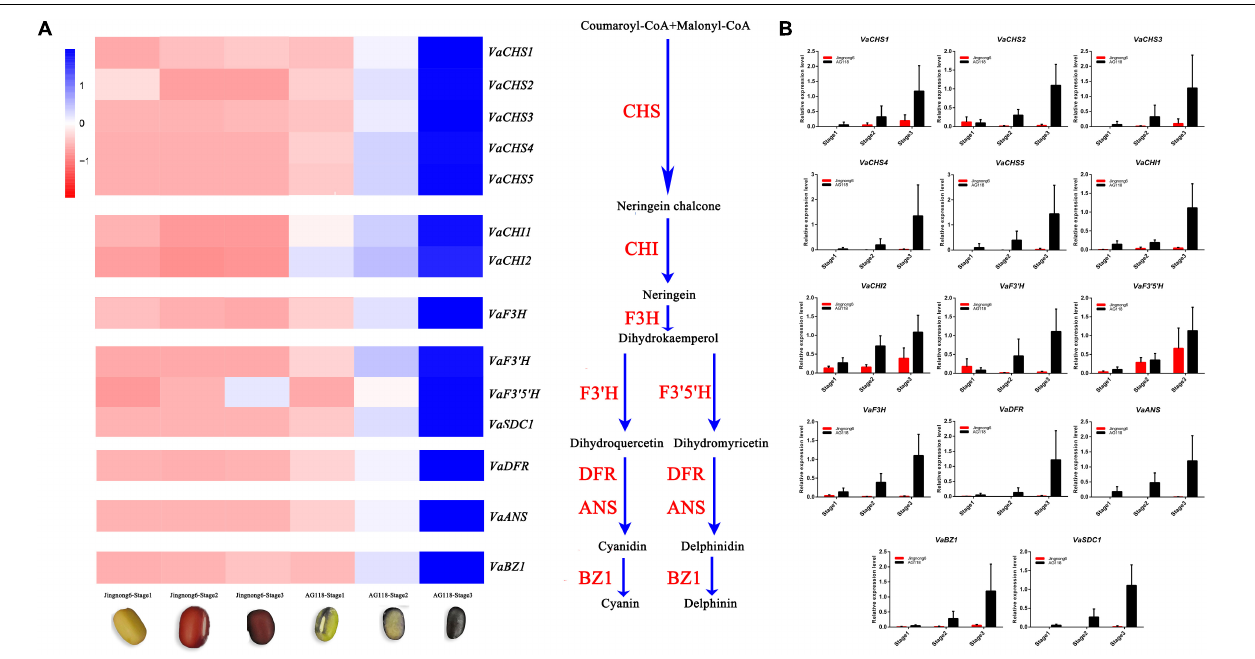
FIGURE 4 | Differences in gene expression levels of Jingnong6 and AG118 seed coats. (A) The expression profiles of flavonoid metabolic pathway structural genes in Jingnong6 and AG118 from stage 1 to stage 3 by RNA-Seq; (B) the expression profiles of structural genes of flavonoid metabolic pathways verified by qRT-PCR (mean ± SD from three biological replicates).